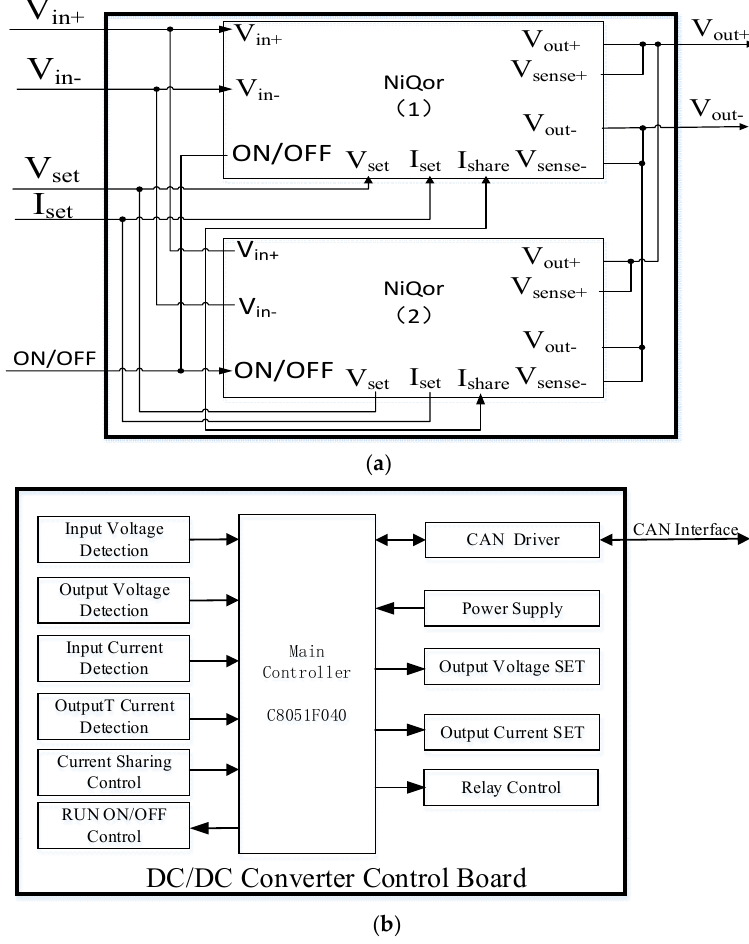
Figure 7. Functional diagram of the DC/DC converter. ( a ) Parallel block diagram of the NiQor module. ( b ) Control board functional diagram of the DC/DC converter.